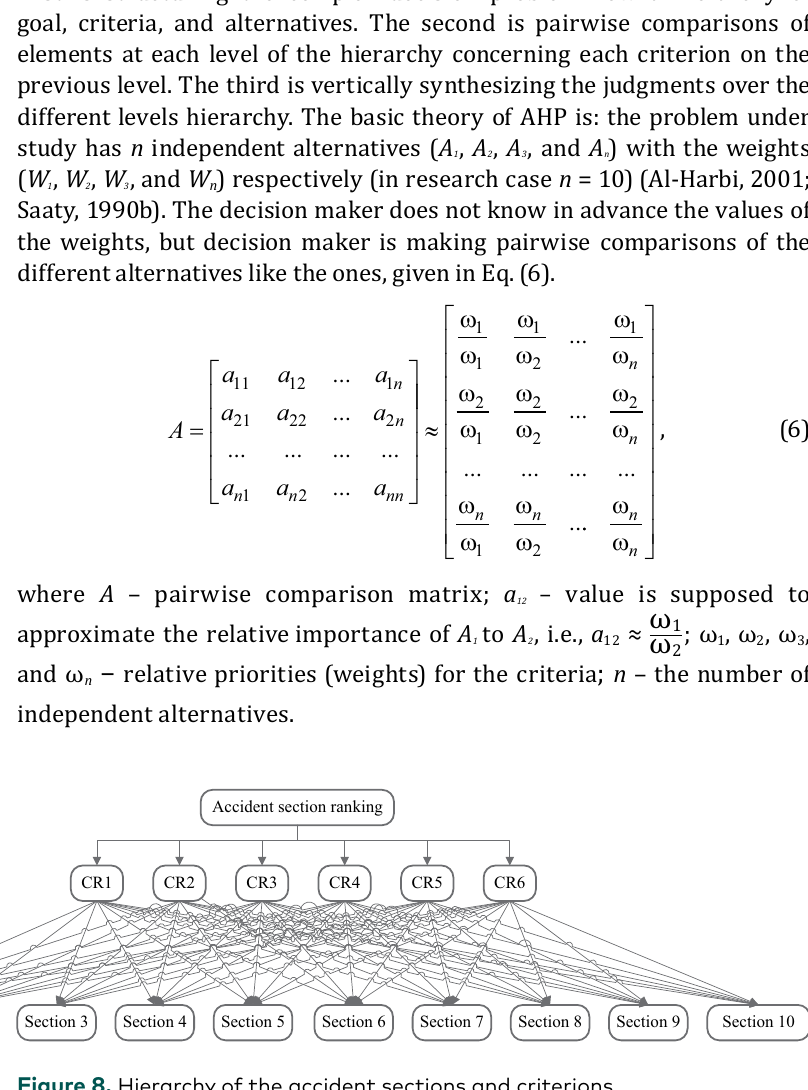
Figure 8. Hierarchy of the accident sections and